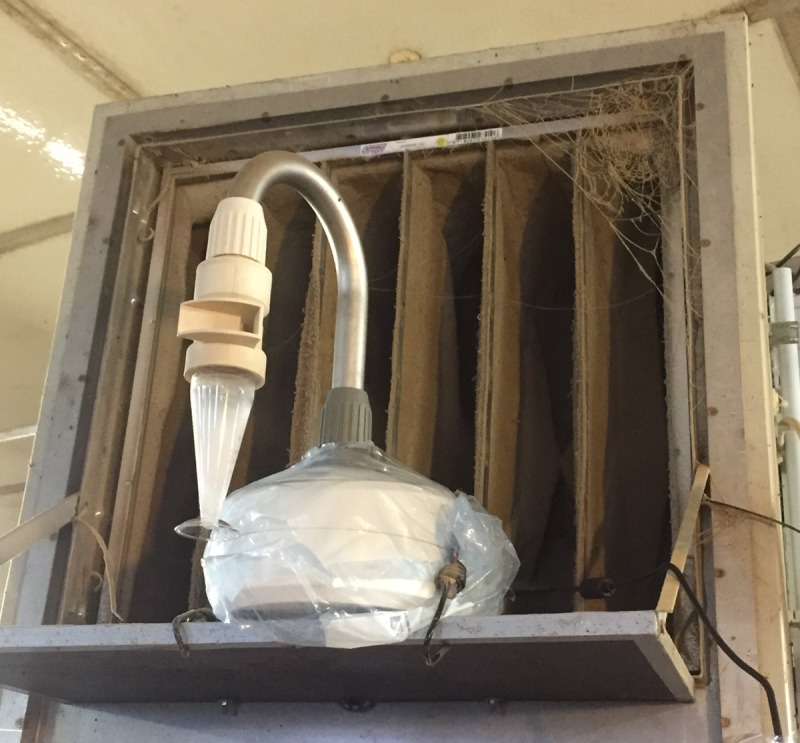
Position of the Coriolis®μ Air Sampler in front of the UVC module.The picture shows the Coriolis®μ Air Sampler operating on a mounted board in front of the pocket filter for measurements in close proximity to the UVC module.